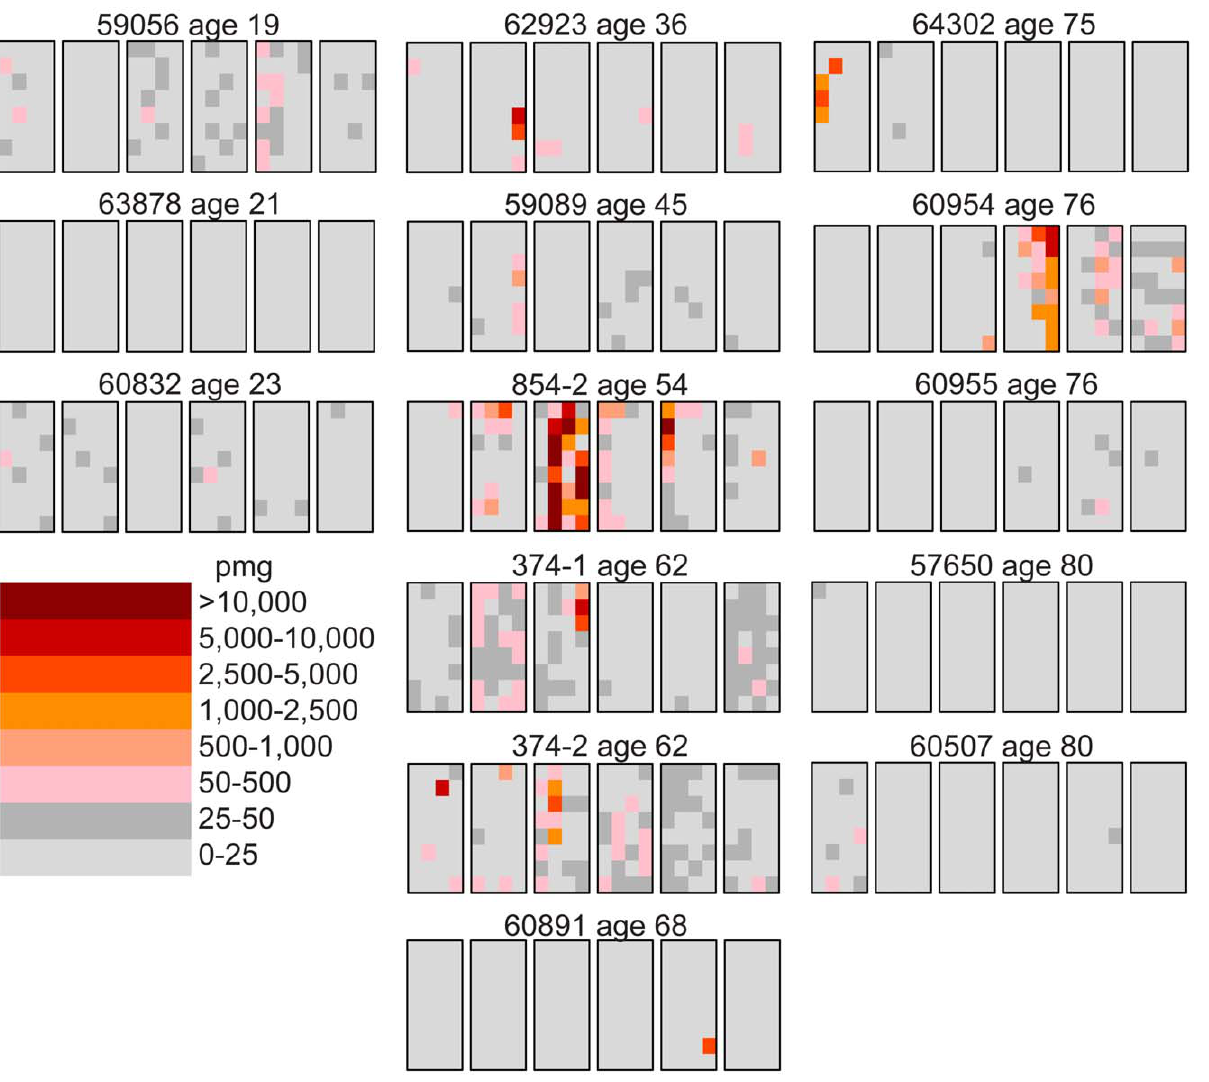
Figure 1. Distribution of the MEN2B mutations in 14 human testes. Each testis is cut into 6 slices, and each slice is further dissected into 32 approximately equal pieces. The mutation frequency per million genomes (pmg) in each piece is represented by the color code in the lower left-hand corner of the figure. Above each testis is the identification number and the age of the donor. The testes are organized by age: the left-hand column is the youngest age group (19 to 23 years), the middle column is the middle-aged group (36 to 68 years), and the right-hand column is the oldest age group (75 to 80 years).